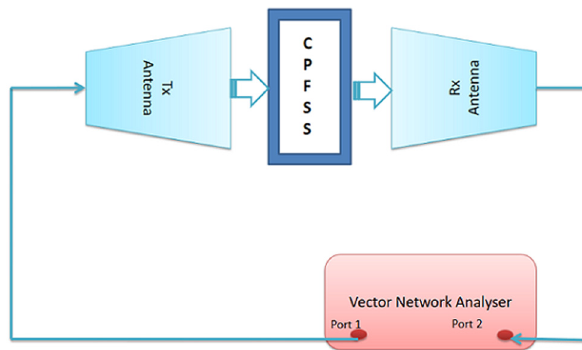
Figure 11: Experimental set up for measuring the transmission coe ffi cient of the